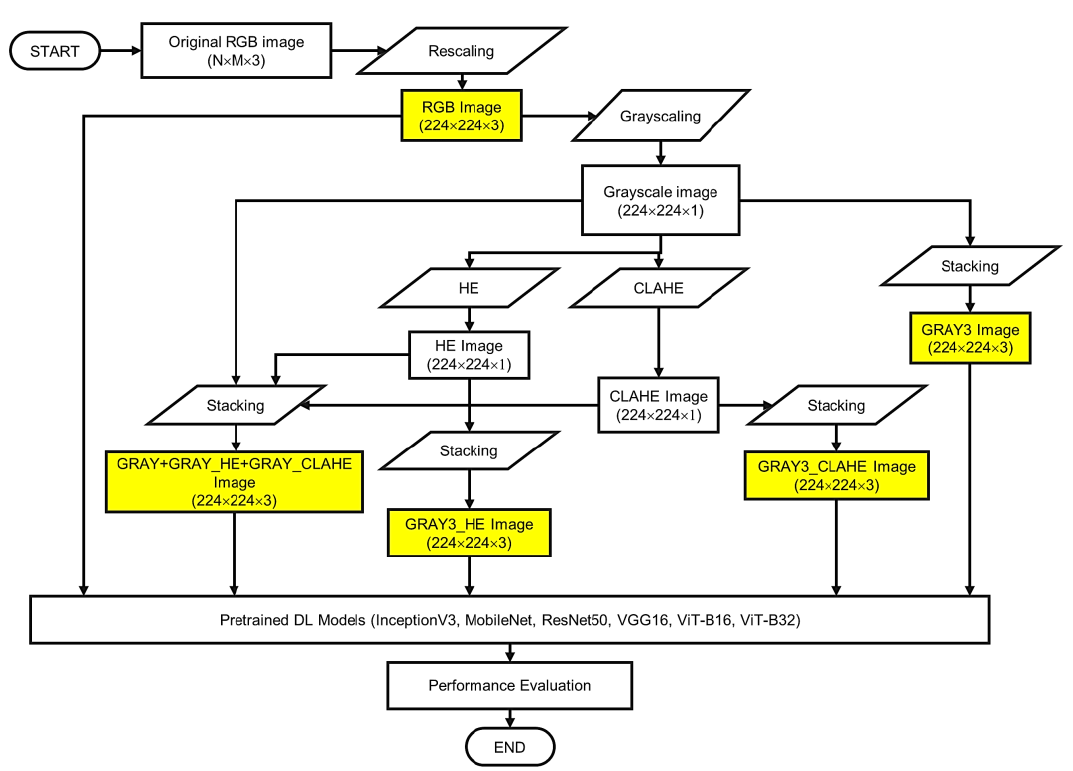
Figure 1. Flowchart of the proposed methodology with details on the data pre-processing phase. N and M represent the height and width of the image, respectively.